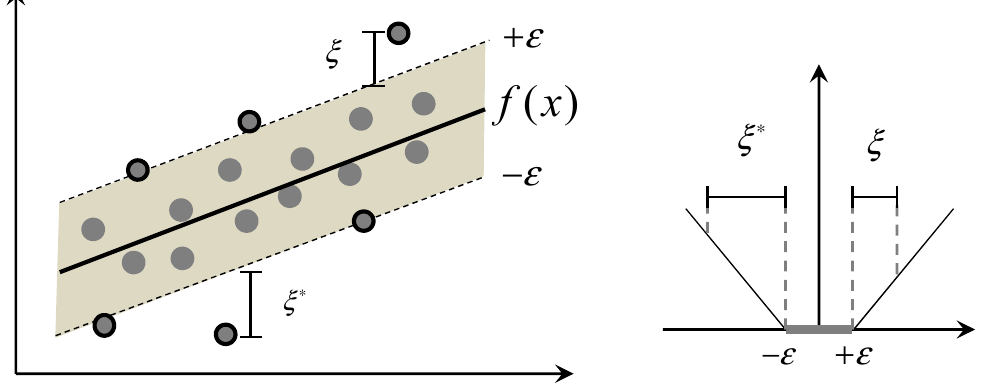
Figure 1. Schematic of linear support vector regression (SVR) and the ε - intensive loss function (circles with black outline are support